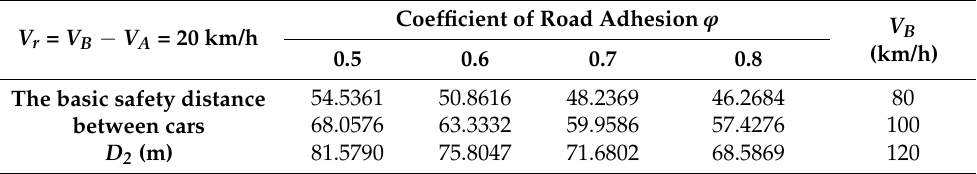
Figure 12. Changes in the basic following distance with V B and ϕ when i = 0, V r = 20 km/h. Table 11. The basic following distance based on V B between 60 and 120 km/h when i = 0, V r = 20